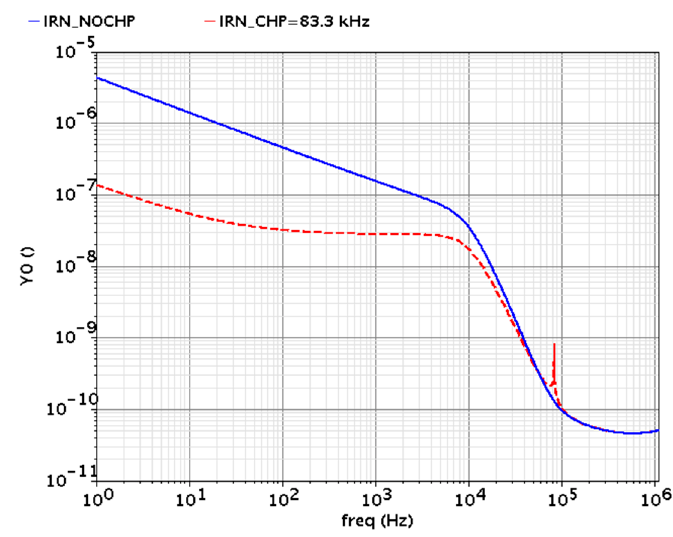
Figure 6. Input-referred noises of the chopper IA before (red dot line) and after (blue solid line) the chopper modulator is activated.